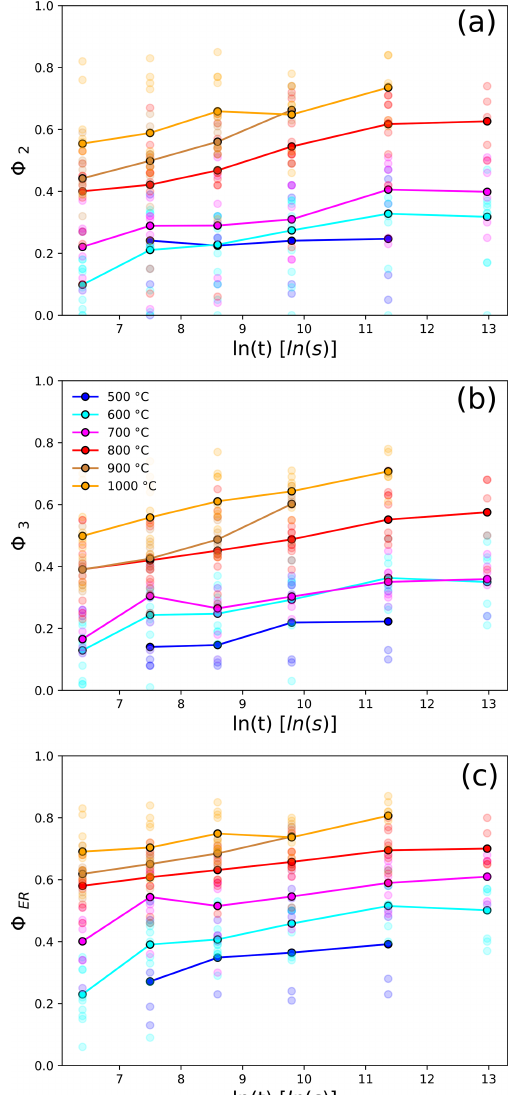
Figure 8. Overview of the JMAK (a–c) and DAE (d–f) modeling results for (cid:48) 2 , (cid:48) 3 , and (cid:48) ER . The left panels compare the predicted and measured (cid:56) values. The right panels show the sum of squared residual (SSR) surfaces as a function of log k 0 and E A (JMAK) or E 0 (DAE) for optimal values of n and σ (Table